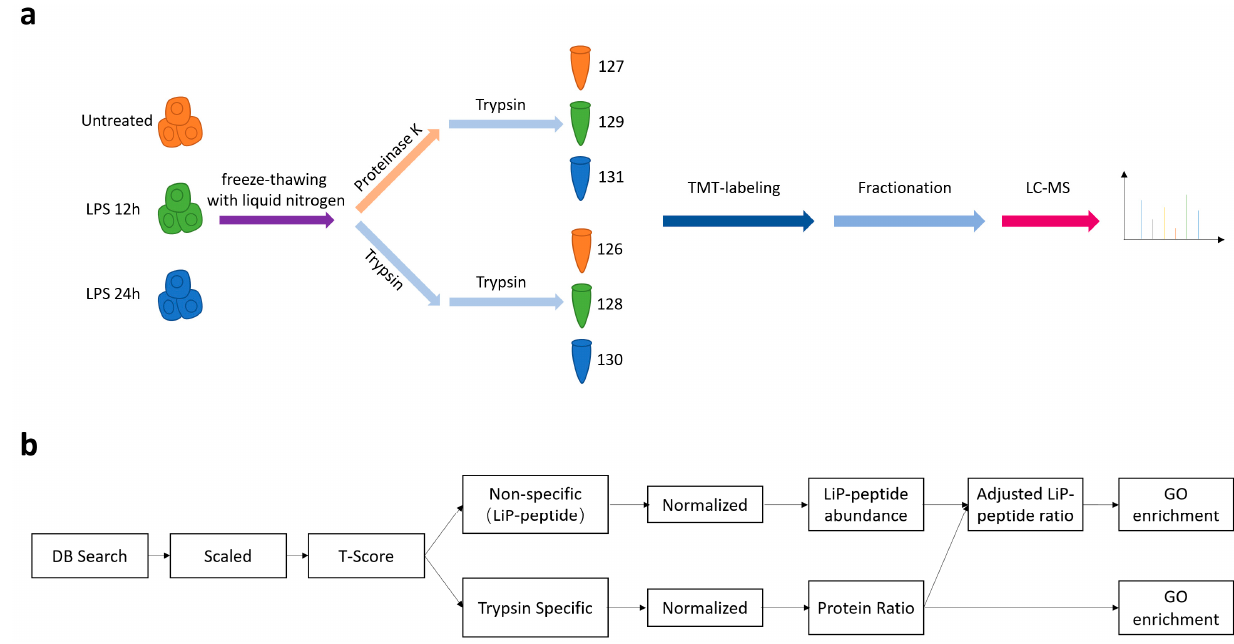
Figure 1. LiP-MS analysis for characterization of the structure-ome. ( a ) Workflow of LiP-MS analysis; ( b ) Workflow for LiP-MS data analysis.